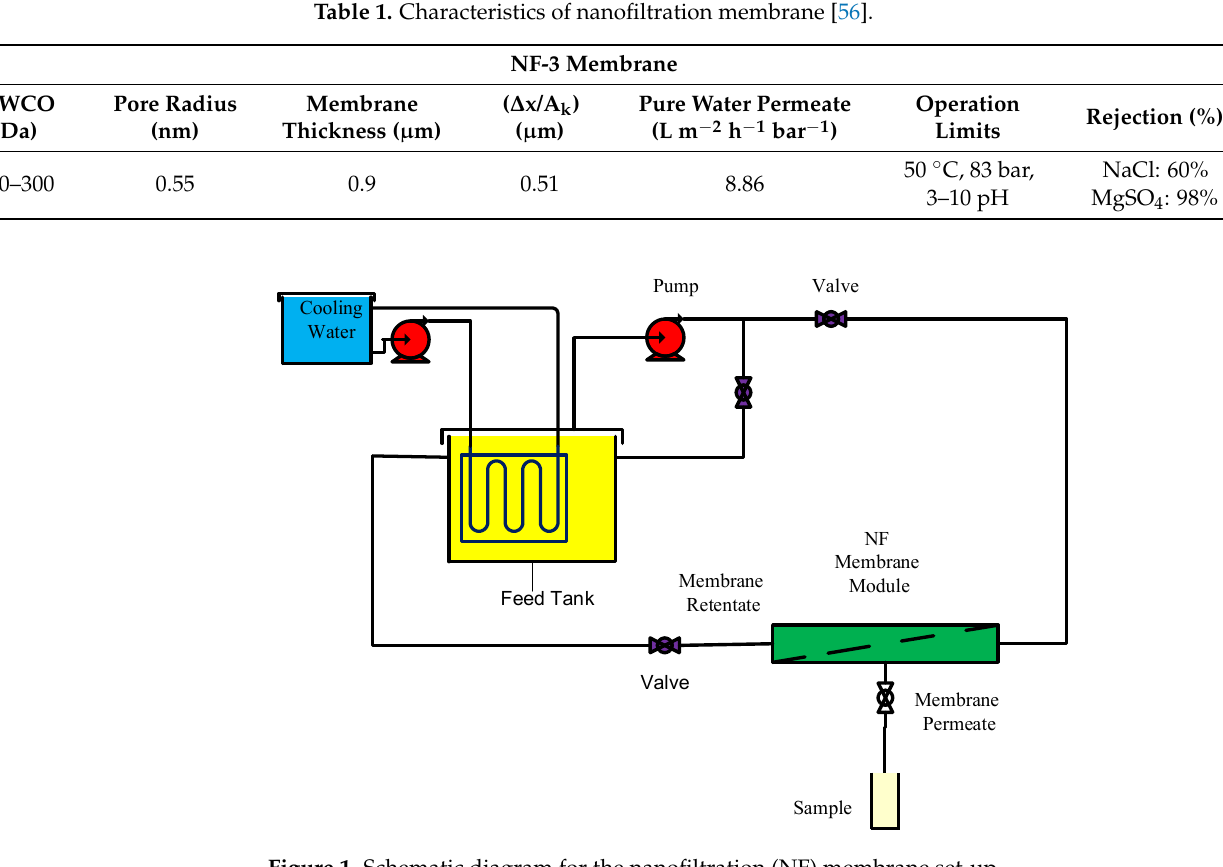
Figure 1. Schematic diagram for the nanofiltration (NF) membrane set-up.